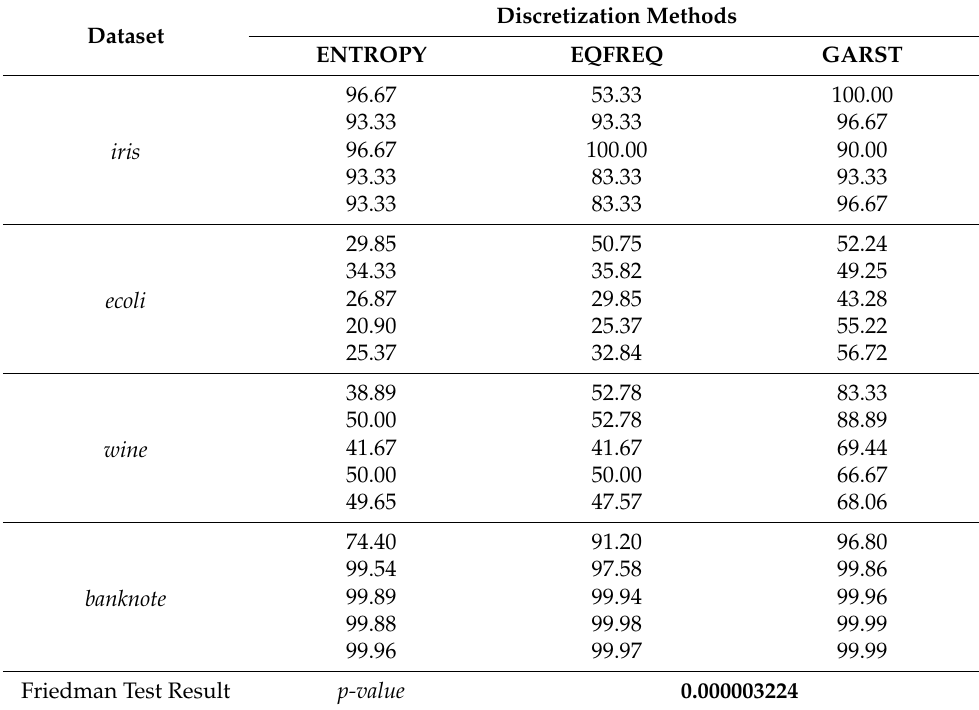
Table 5. The results of Friedman test for the accuracy.